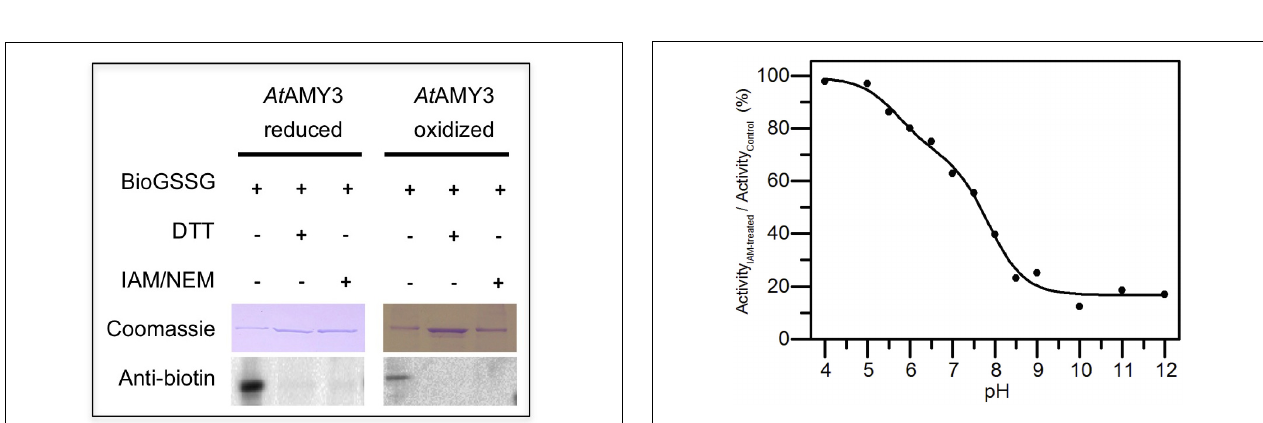
FIGURE 4 | Effect of BioGSSG incubation on reduced and oxidized At AMY3. Protein samples (2 µ M) were mixed with 2 mM BioGSSG for 1 h prior to separation on a non-reducing 12.5% SDS-PAGE and transfer to a nitrocellulose membrane. The reversibility of the reaction was assessed by a 30 min incubation with 80 mM DTT. As negative control, 2 µ M protein sample was alkylated with 100 mM IAM and 20 mM NEM before BioGSSG treatment.